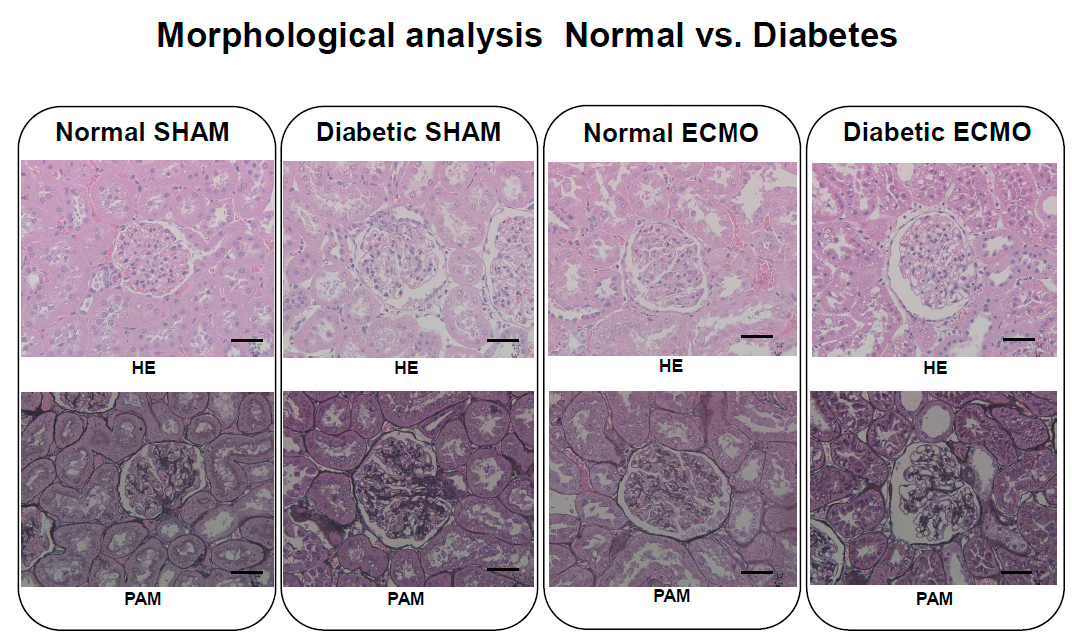
Figure 5. Pathological image of renal tissue (at 200-fold magnification). HE, hematoxylin-eosin; PAM, periodic acid-methenamine-silver stain. Scale bar: 50 µ m. Normal SHAM: Intact. Diabetic SHAM: Slight cytolysis was shown, and the organ structure was maintained. Normal ECMO: Cell injury was similar to the level of diabetic SHAM rats. Diabetic ECMO: Tubular epithelium was desquamated from the basement membrane.